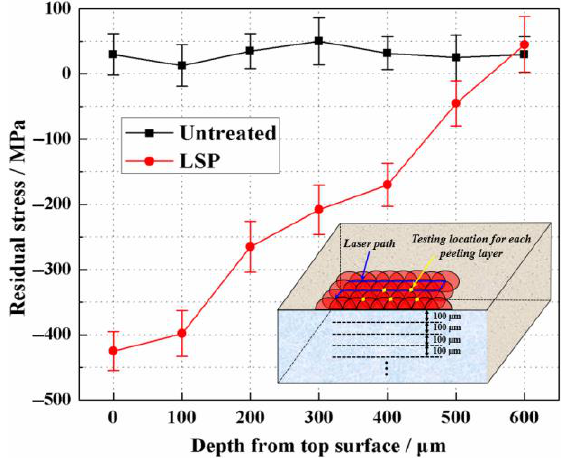
Figure 5. Gradient distribution of the residual stress measured parallel to the laser path of the samples without and with LSP treatments.